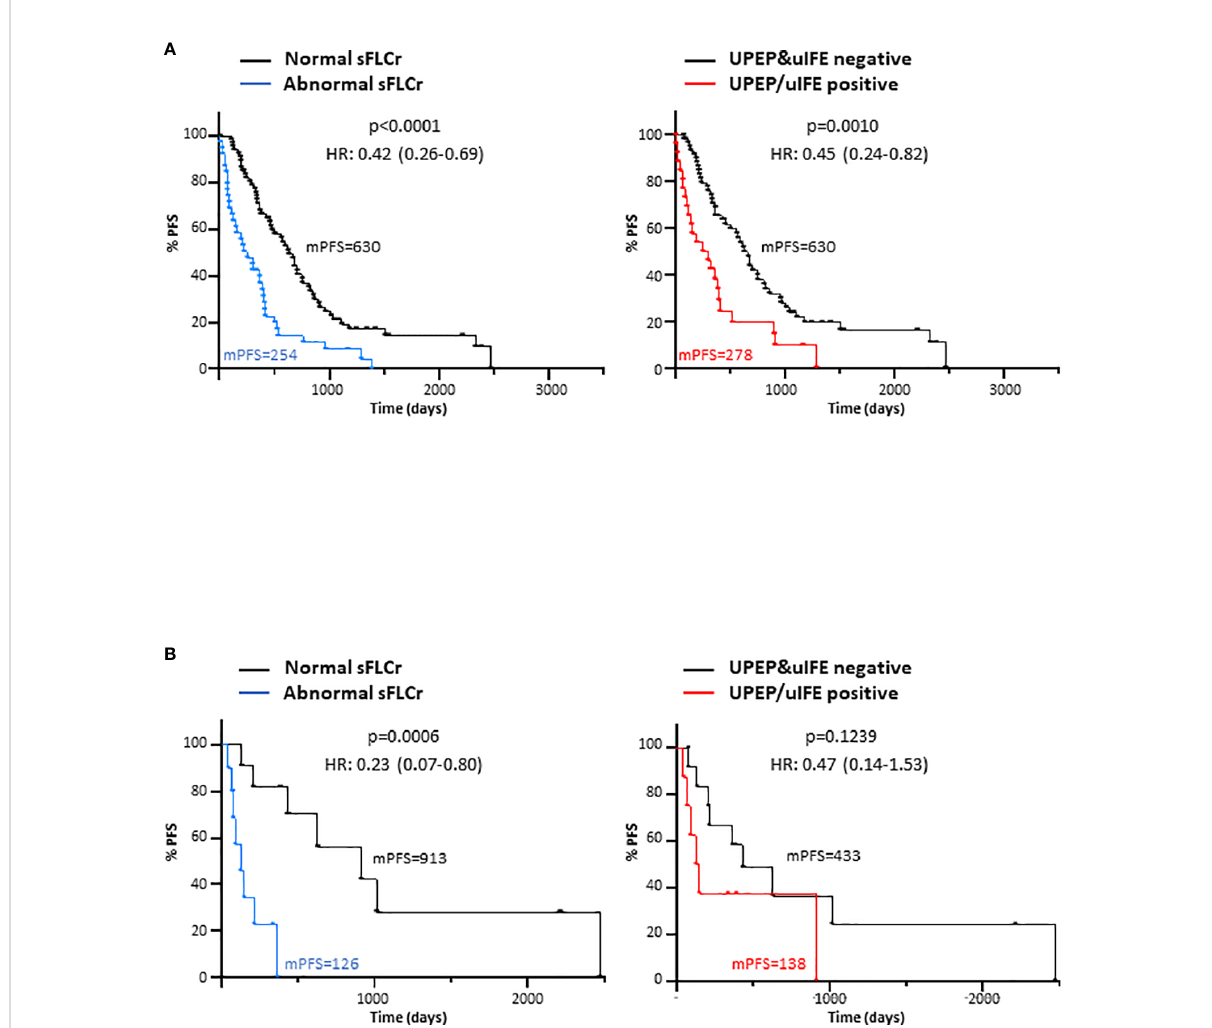
FIGURE 2 Progression-free survival (PFS) according to the normalized sFLCr and negativized 24-hour urine studies at maximum response for the entire patient cohort (A) and for LCMM patients (B) . mPFS, median progression-free survival; HR, Hazard ratio; sFLCr, serum free light chains ratio; uIFE, urine immuno fi xation electrophoresis; UPEP, urine protein